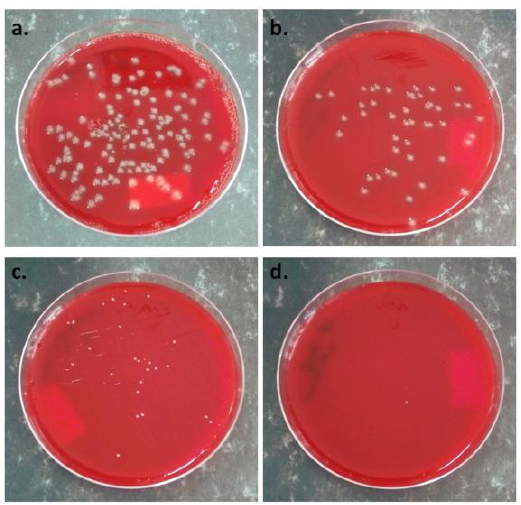
Figure 14. Antibacterial activity of PHB-2BC nanocomposite films against Escherichia coli before ( a ) and after the plasma treatment ( b ) and against Staphylococcus aureus before ( c ) and after ZnO plasma coating ( d ).